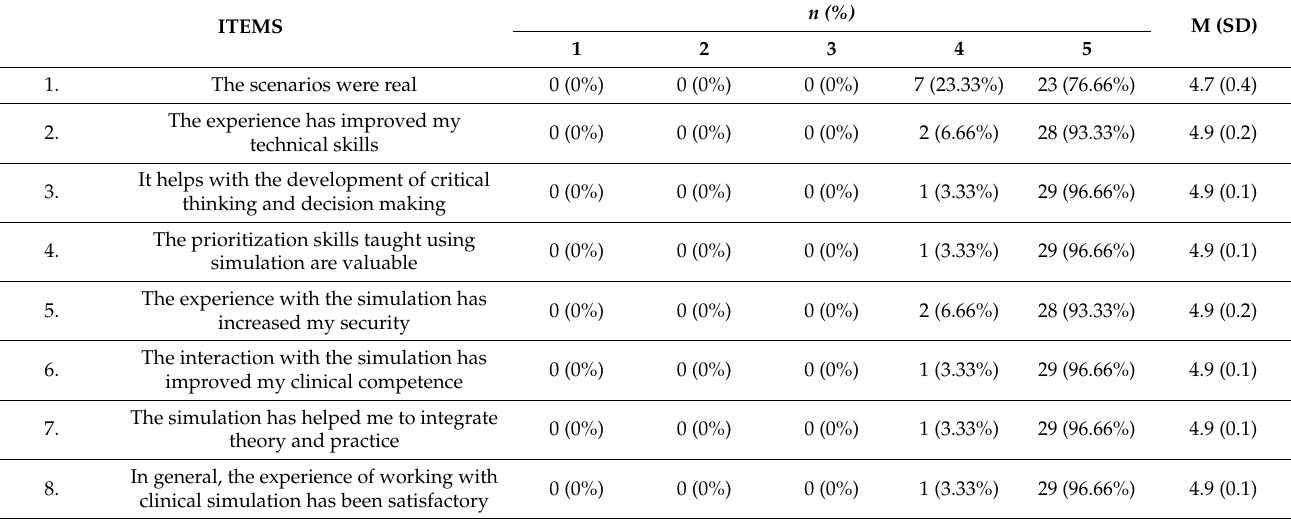
Table 8. Descriptive statistics of the satisfaction